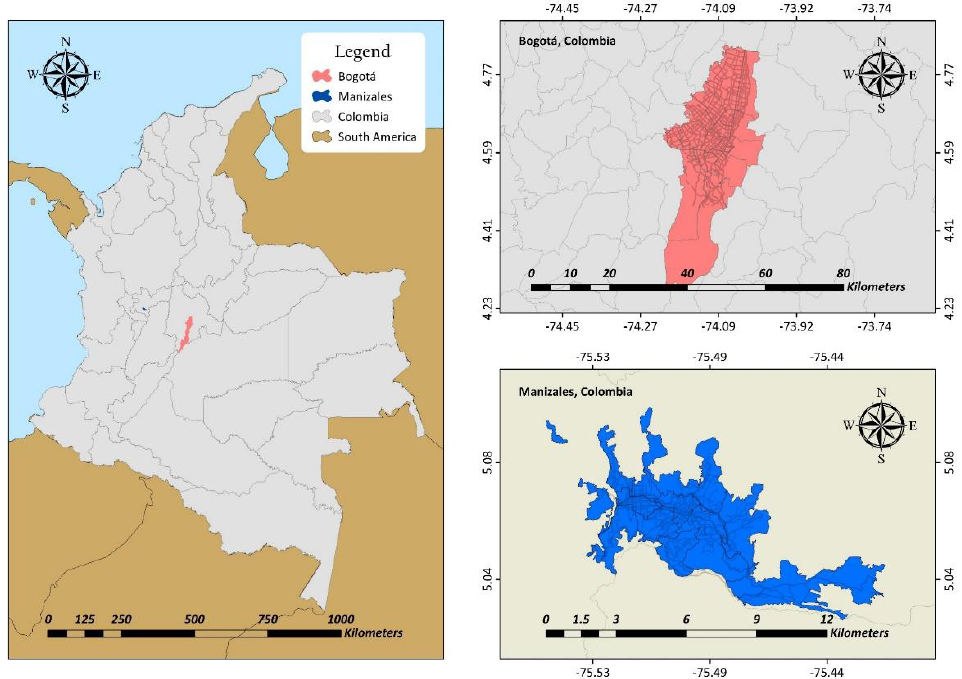
Figure 1. Location of the study cities—Bogotá and Manizales, Colombia.